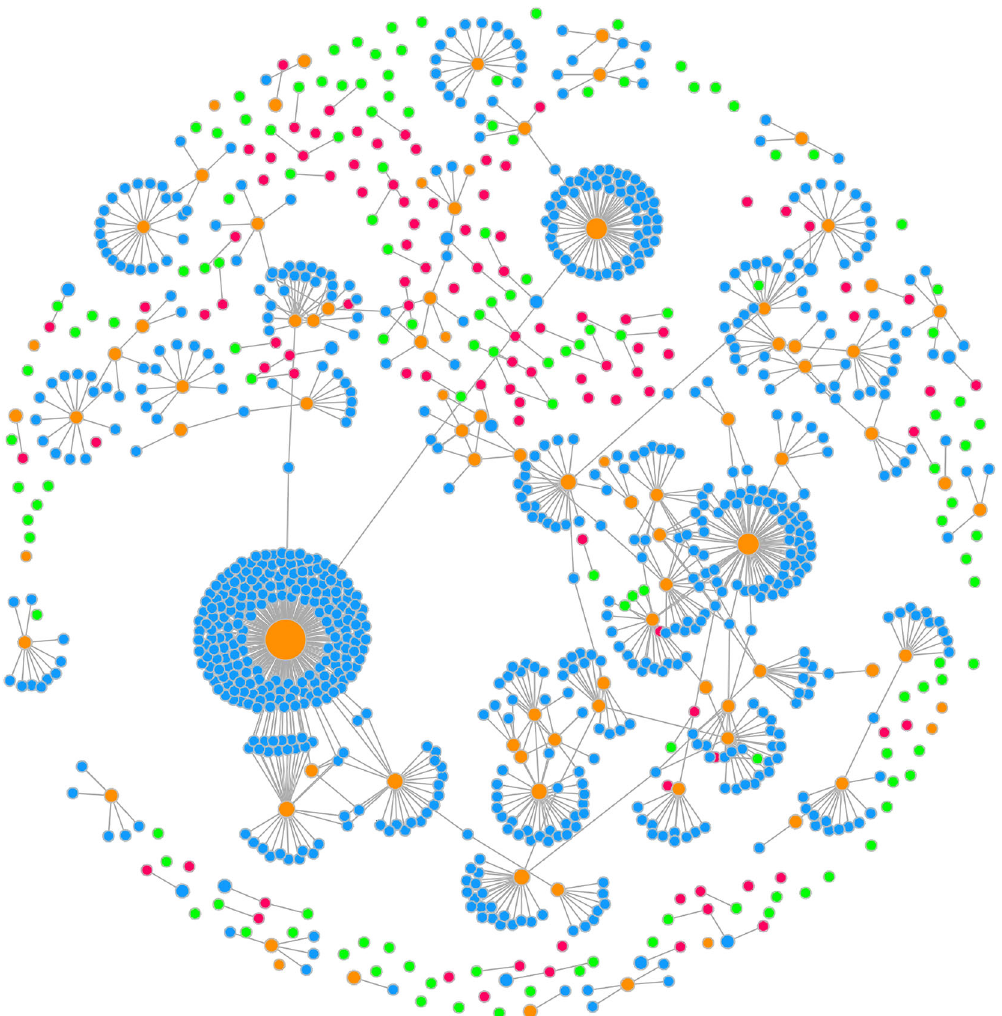
Figure 4. An interactive visualization created by SPARClink showing the connected nature of all SPARC